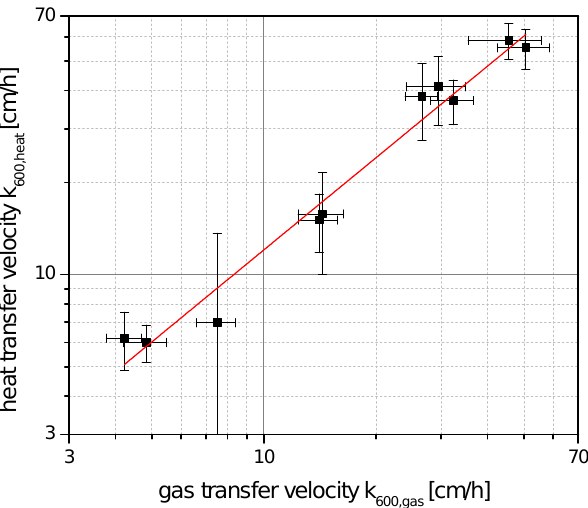
Figure 8. Heat transfer velocities plotted against simultaneously measured gas transfer velocities, both scaled to a Schmidt number of Sc = 600. The best-fit line has a slope of 1 . 20 ± 0 .